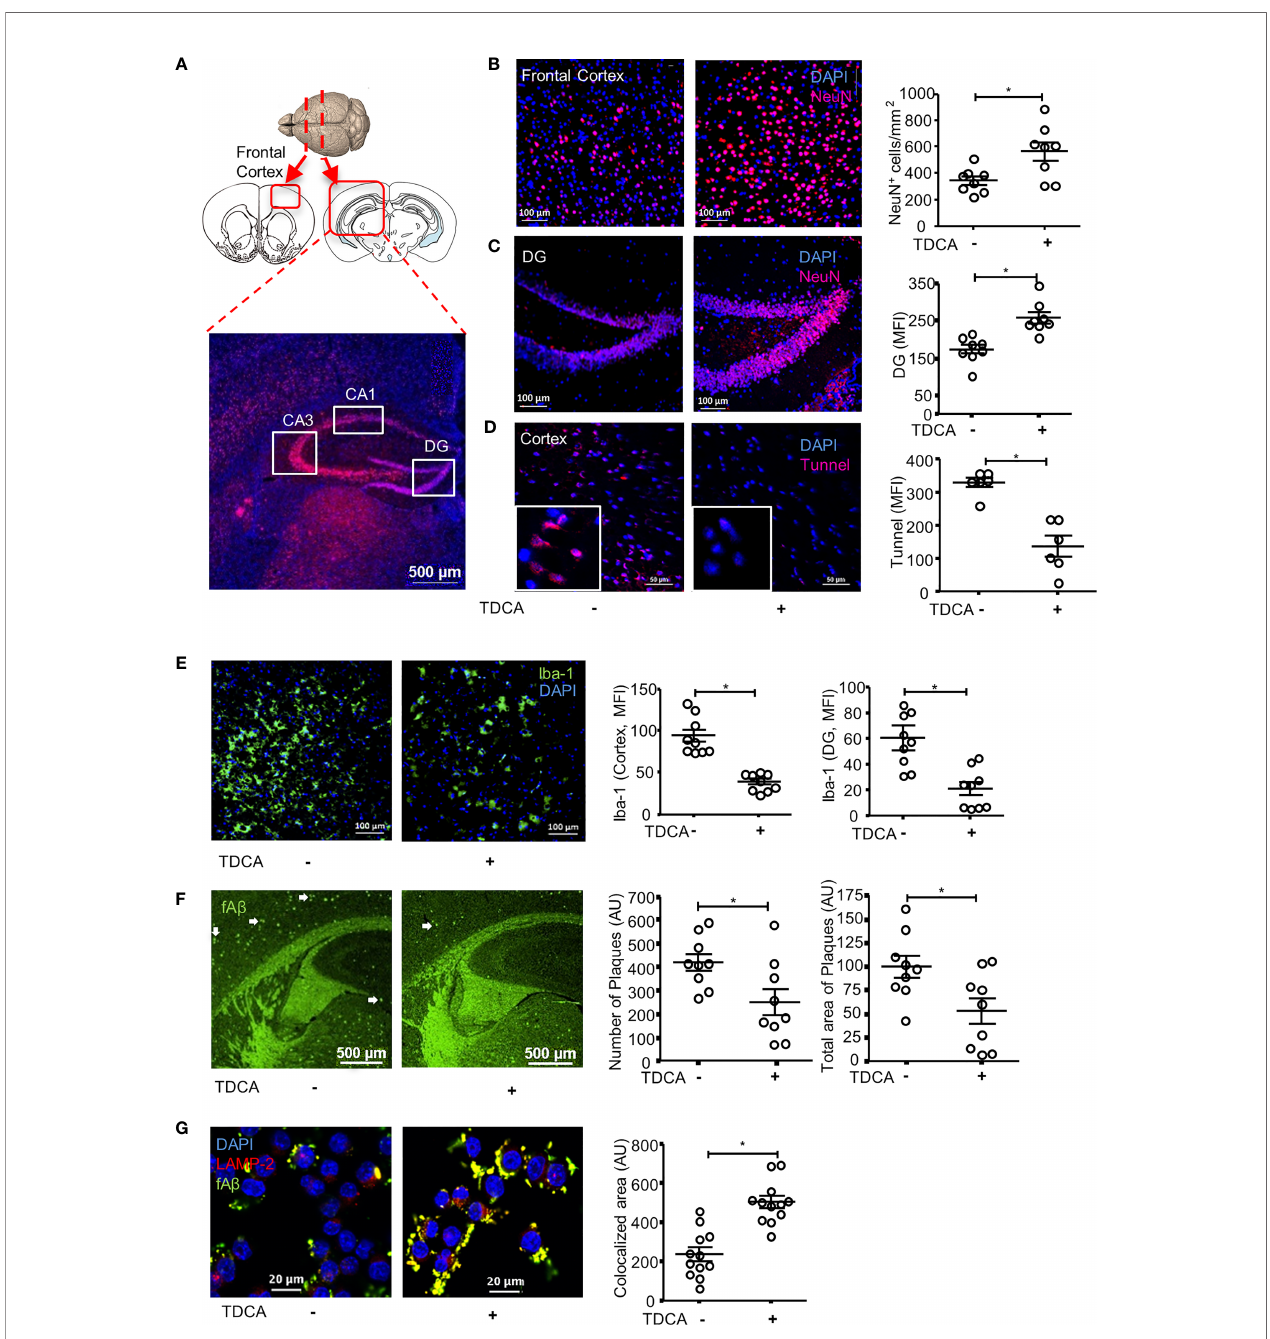
FIGURE 4 | TDCA prevents apoptosis of neurons, decreases reactive microgliosis and A b plaques in the brain. (A) , 5xFAD mice (n = 8/group) were treated with 1 mg/kg TDCA i.p. for 10 weeks. NeuN + cells in the frontal cortex and hippocampus were analyzed using confocal microscopy. Paraf fi n sections were made from the frontal cortex (B) and DG of the hippocampus (C) . A set of representative images is depicted in the left panel, and the number of NeuN + cells (B) or MFI ± SEM (C) is shown in the right panel. (D) , Apoptotic cells in the brain were quantitated after TUNEL staining. The nuclei were stained with DAPI (blue). (E) , Reactive microgliosis in the frontal cortex and DG of 5xFAD mice analyzed with confocal microscopy after staining with anti-Iba-1 Ab (left panel). (F) , A b plaques in the brain sections were stained with thio fl avin-S (green dots indicated with white arrows). The number of plaques and total area of plaques were quantitated using ImageJ. (G) , The effects of TDCA (400 ng/ml) on phagocytosis of fA b by BV2 cells were tested. Colocalization (yellow) of fA b (green) with phagosomes were determined using confocal microscopy after staining with anti-LAMP2 + Ab (red). The area of colocalization (yellow) were quanti fi ed using ImageJ from four independent experiments (triplicate, right panel). The individual samples are shown with the mean ± SEM and *P < 0.05 using Student ’ s unpaired